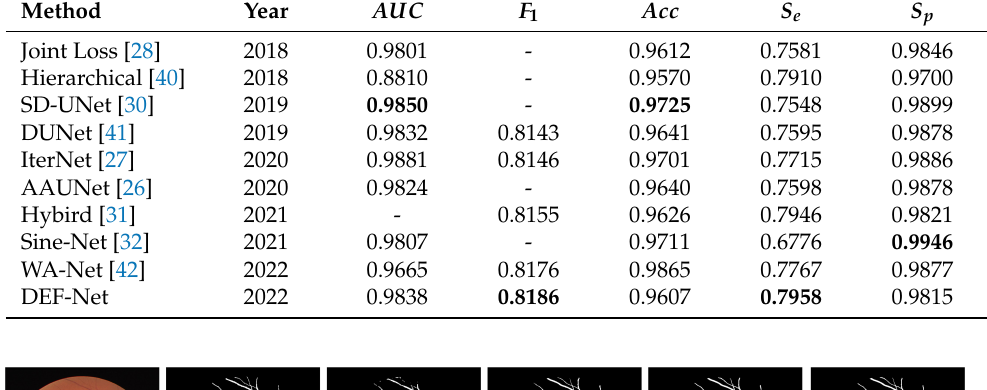
Table 6. Comparison results with advanced methods on STARE dataset.